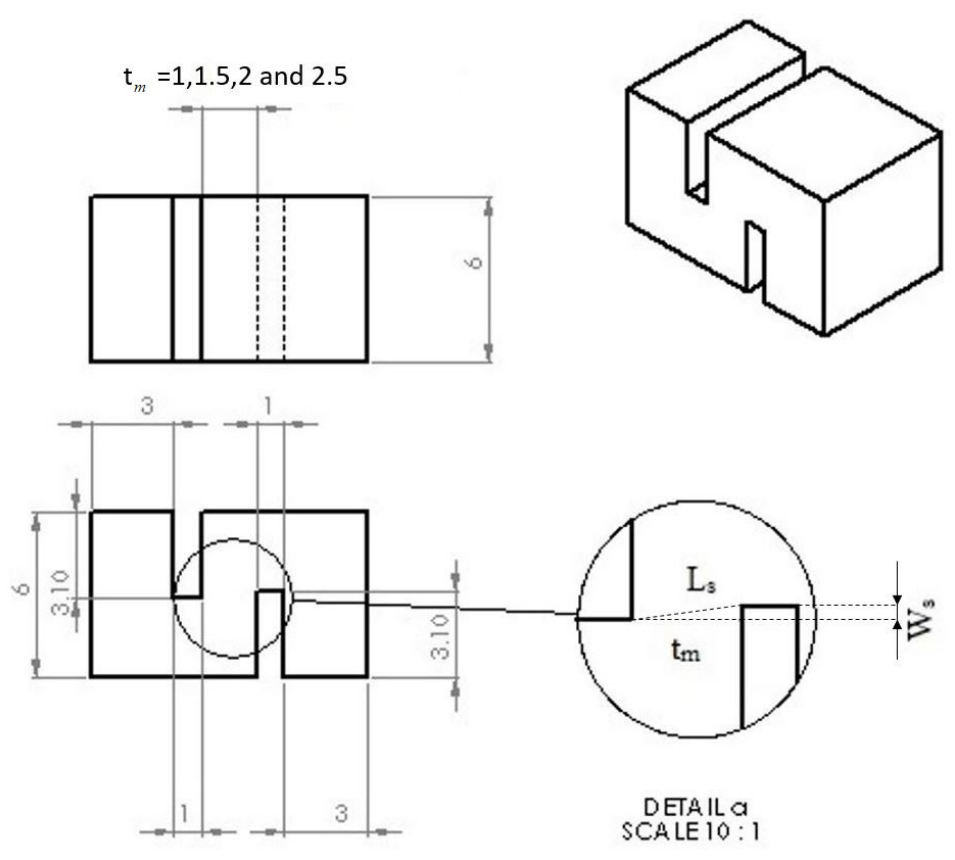
Figure 1. Schematic design of the new S-shaped sample (NSSS).